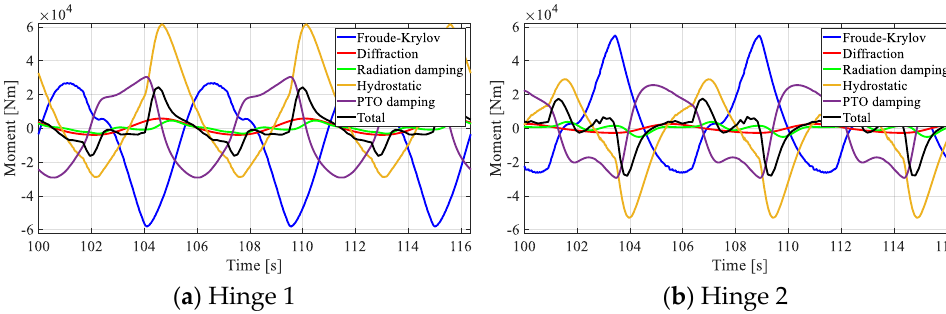
Figure 20. Time history of moment components acting on the hinge points in the Buan area.